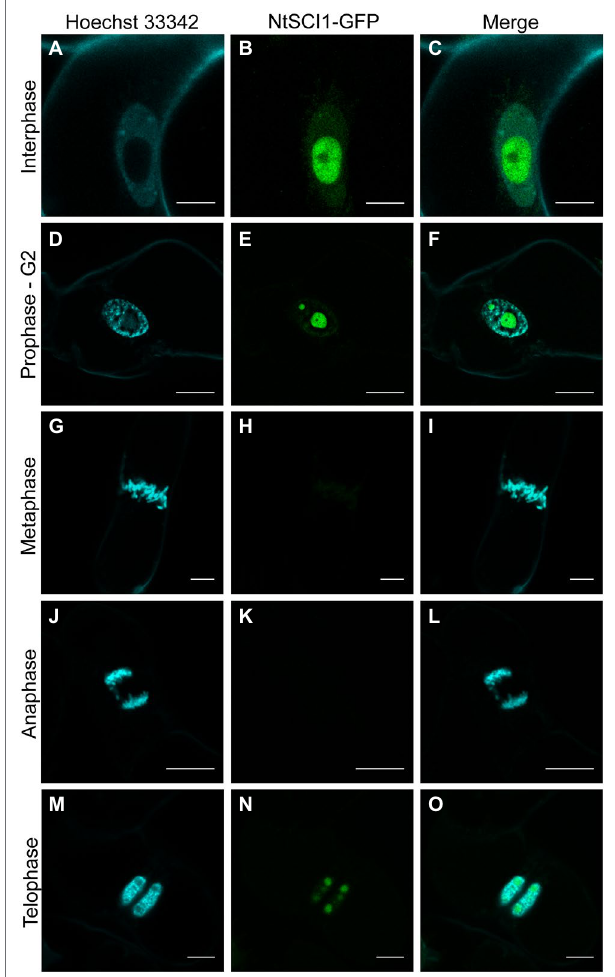
FIGURE 4 | Stigma/Style Cell-Cycle Inhibitor 1 (SCI1) dynamics throughout cell-cycle progression. Confocal microscopy images showing SCI1-GFP subcellular localization in each cell-cycle phase. Tobacco BY-2 cells stably transformed with 35S prom ::SCI1-GFP were stained with Hoechst 33342. Images were captured using Leica TCS SP5 (Leica Microsystems). Scale bars—10 μ m (A–C) and 20 μ m (D–O)